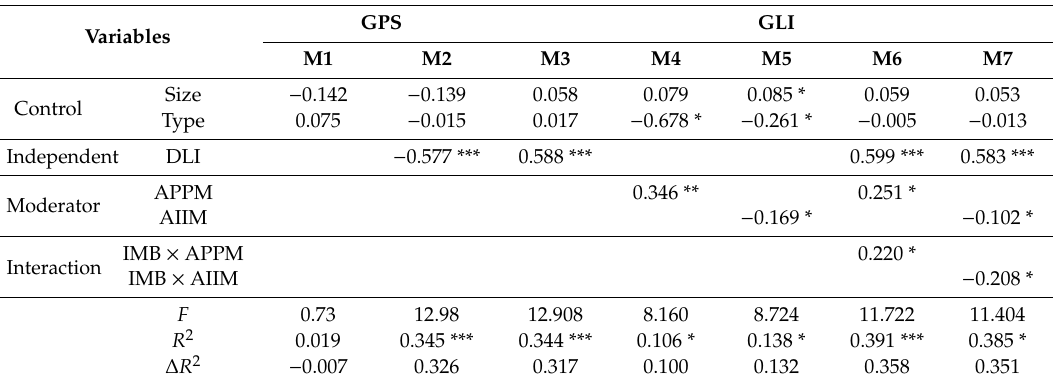
Table 3. The main and moderating e ff ects ( N =